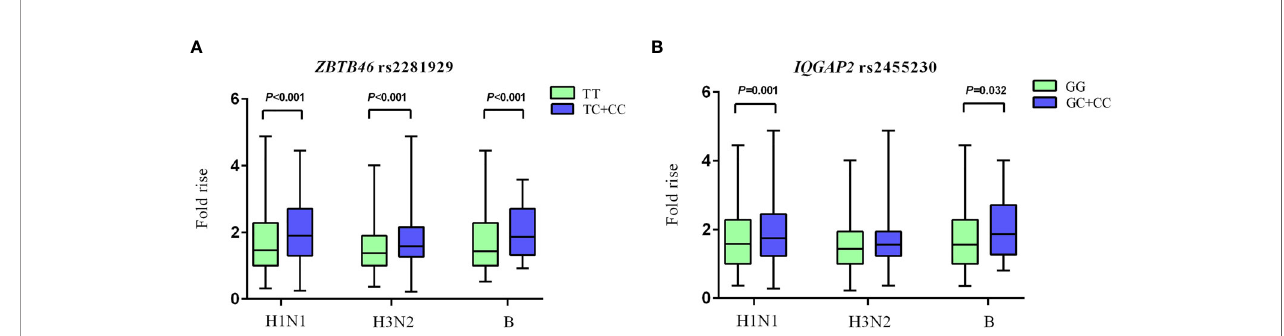
FIGURE 3 | Comparison of antibody fold rises against different vaccine strains. (A) The comparison of antibody fold rises between ZBTB46 rs2281929 TT genotype and TC+CC genotype to H1N1, H3N2 and B. (B) The comparison of antibody fold rises between IQGAP2 rs2455230 GG genotype and GC+CC genotype to H1N1, H3N2